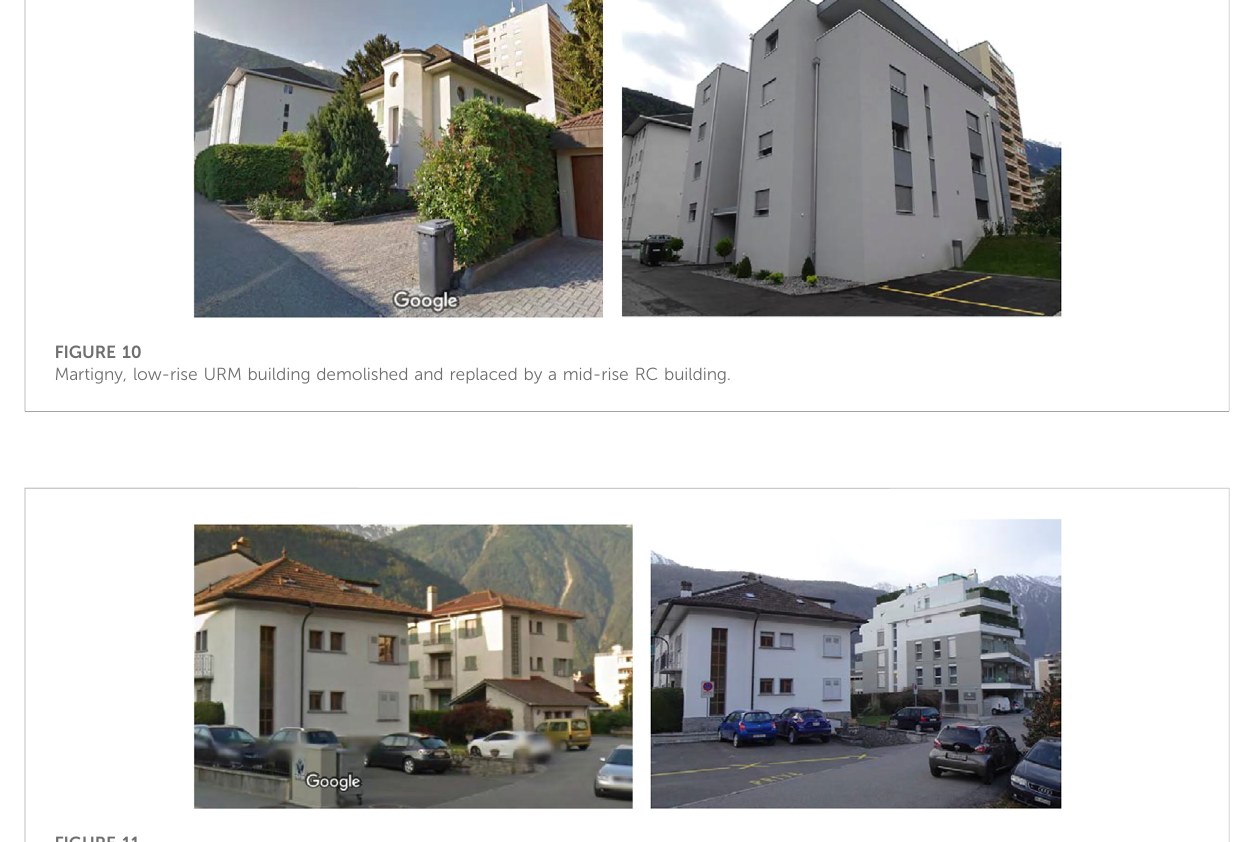
Frontiers in Built